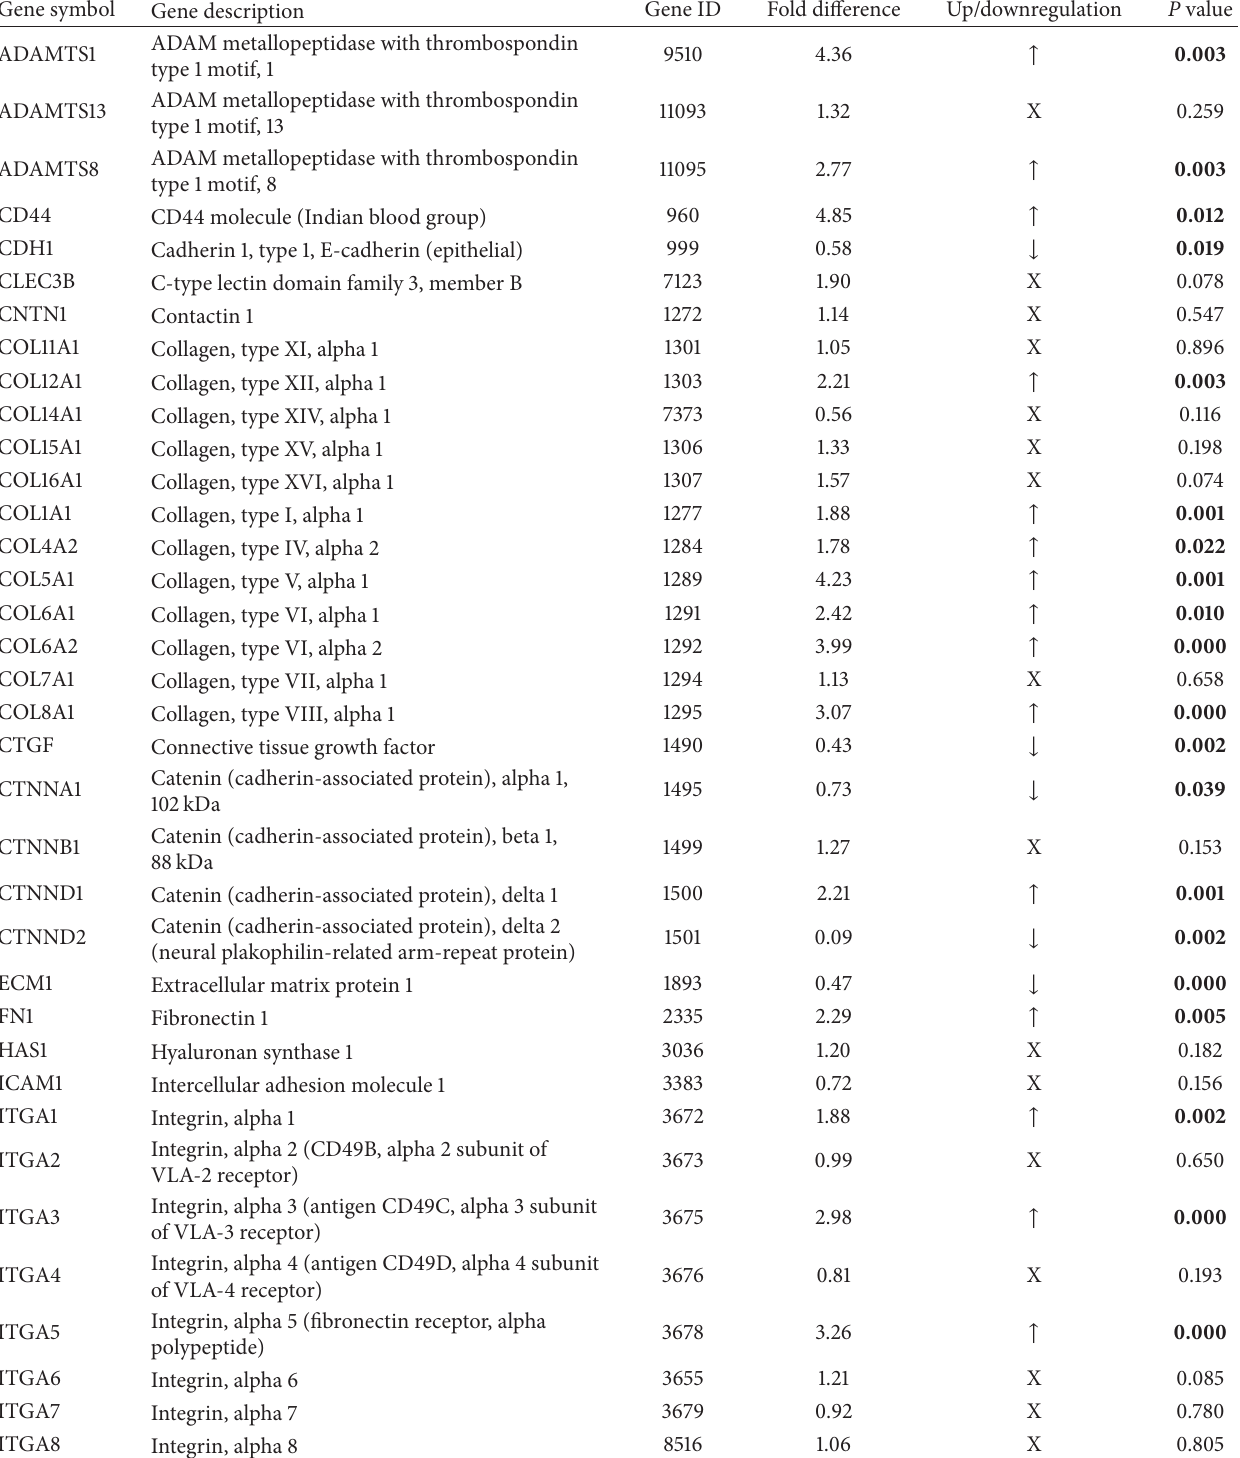
Table 3: Gene expression profile in normal (N) cells irradiated at 660nm. Total RNA from nonirradiated N cells and irradiated N cells were characterised in triplicate. A fold difference > 1 is considered as gene upregulation, while a fold difference < 1 is considered as gene downregulation.Folddifferencesareindicatedasupregulation( ↑ )ordownregulation( ↓ ).Xdenotesthenonsignificantgenesinthatparticular cell